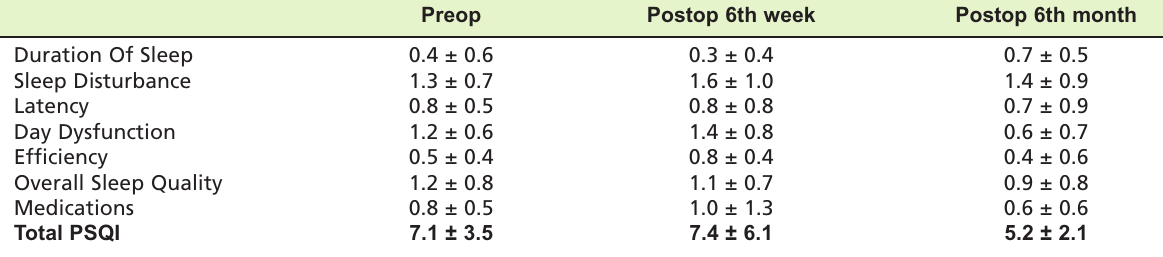
Total and subdimensional PSQI scores of participants Table II: